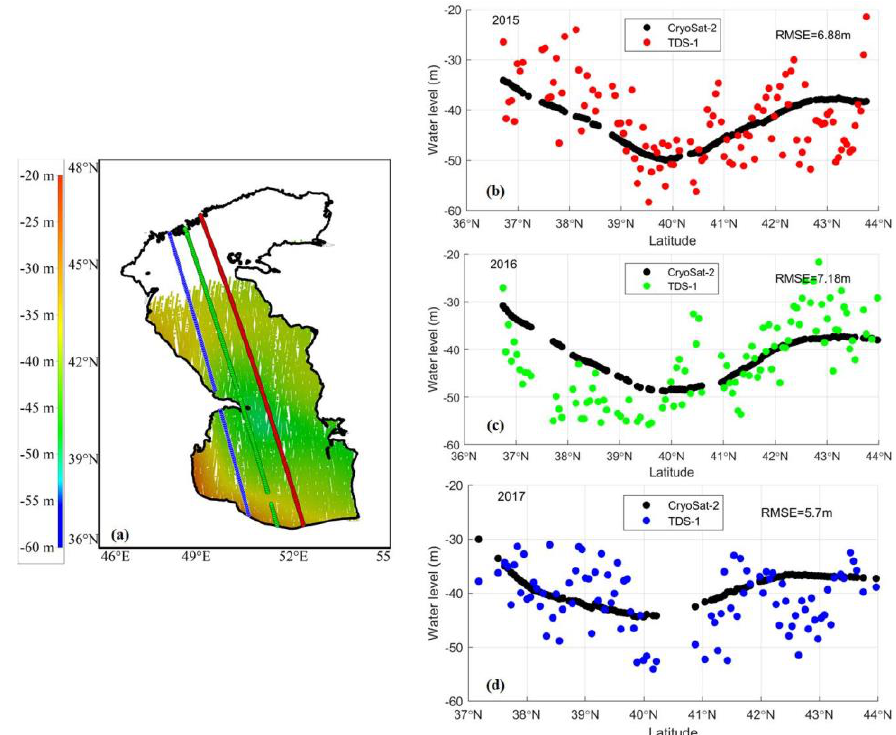
Figure 4. Spatial distributions of water level with respect to WGS84 ellipsoid over the Caspian Sea. ( a ) Map of three TDS-1 tracks for the Caspian Sea from 06 / 07 / 2015 (red), 08 / 08 / 2016 (green), and 06 / 11 / 2017 (blue), respectively. The background map shows the spatial variations of water levels observed by CryoSat-2 in 2015; ( b – d ) spatial variations of water levels observed by the corresponding TDS-1 tracks in (a), with CryoSat-2 derived water levels of the same year as a contrast.